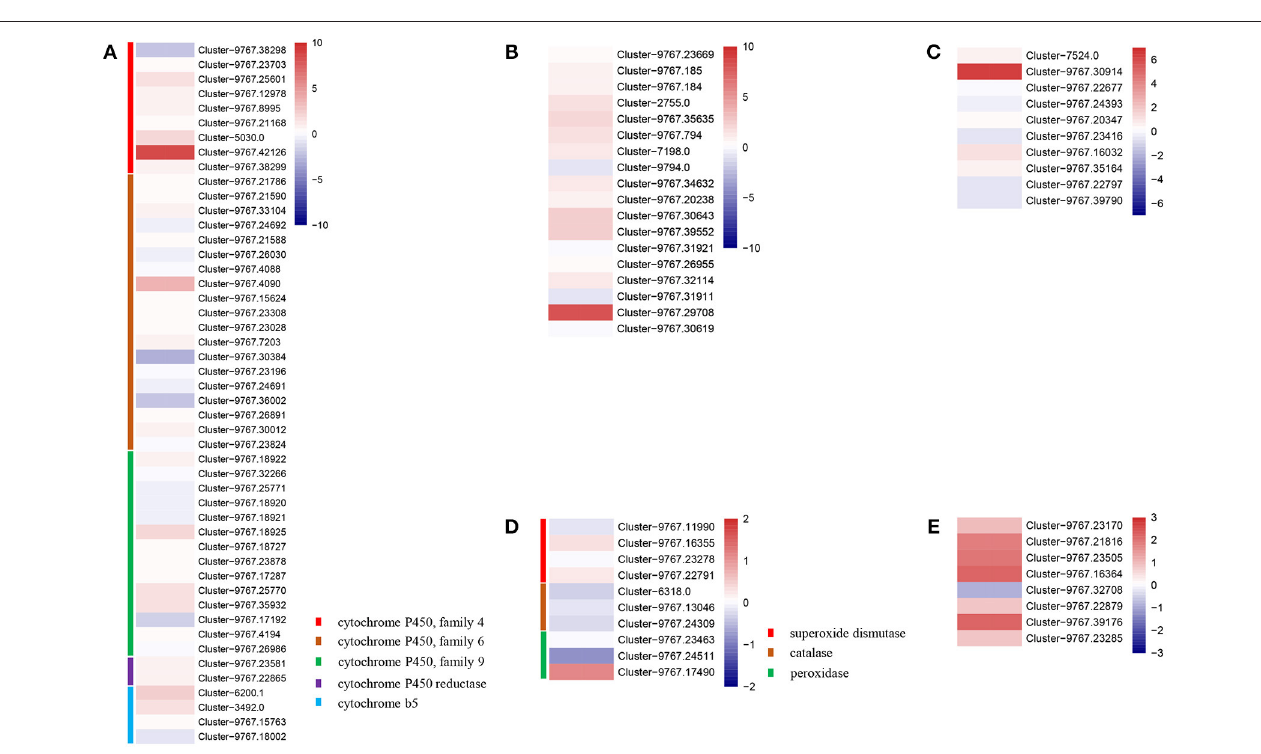
FIGURE 5 | Heatmaps of expressions for genes with detoxification and stress response. (A) Genes involved in cytochrome P450. (B) Genes identified as carboxylesterase. (C) Genes identified as glutathione S-transferees. (D) Genes involved in antioxidant enzymes. (E) Gene identified as heat-shock proteins.